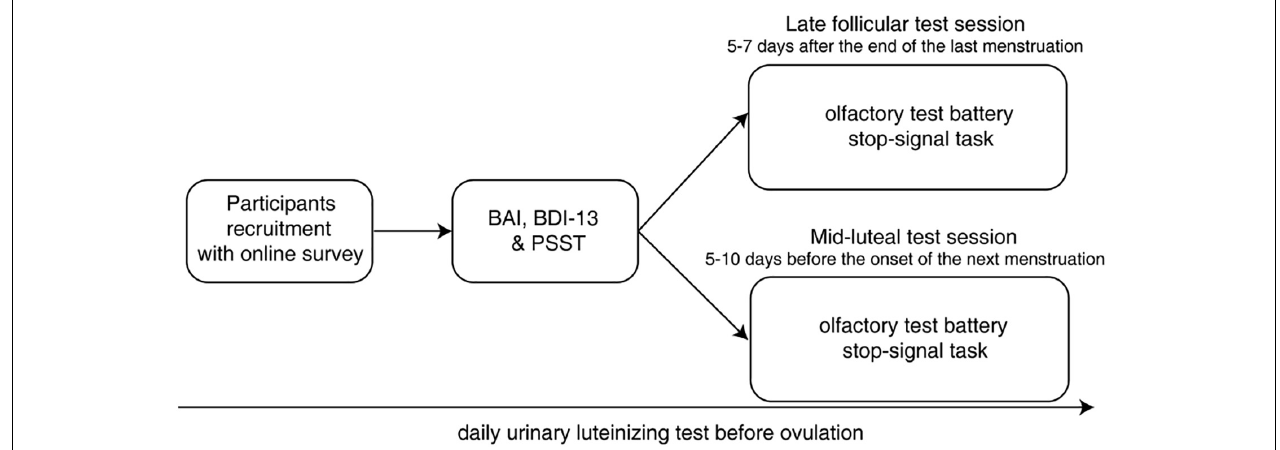
FIGURE 1 | Experimental procedure of the current study. BAI, Beck Anxiety Inventory; BDI-13, Beck Depression Inventory; PSST, Premenstrual Symptoms Screening Tool.